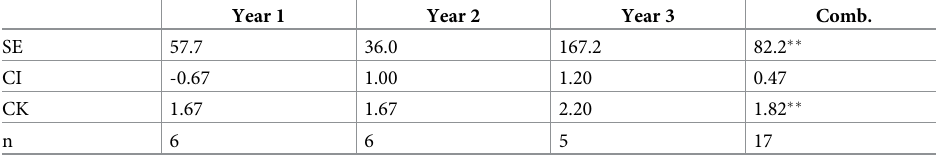
Table 4. Average gains in self-efficacy, career interest and career knowledge in DIVAS Seminar I.